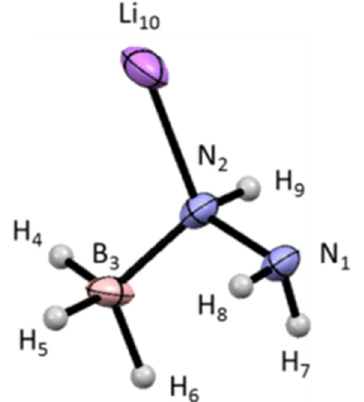
Figure 6. Asymmetric unit with labels of lithium hydrazinidoborane LiN 2 H 3 BH 3 . Reprinted with permission from [66]. Copyright 2014 American Chemical